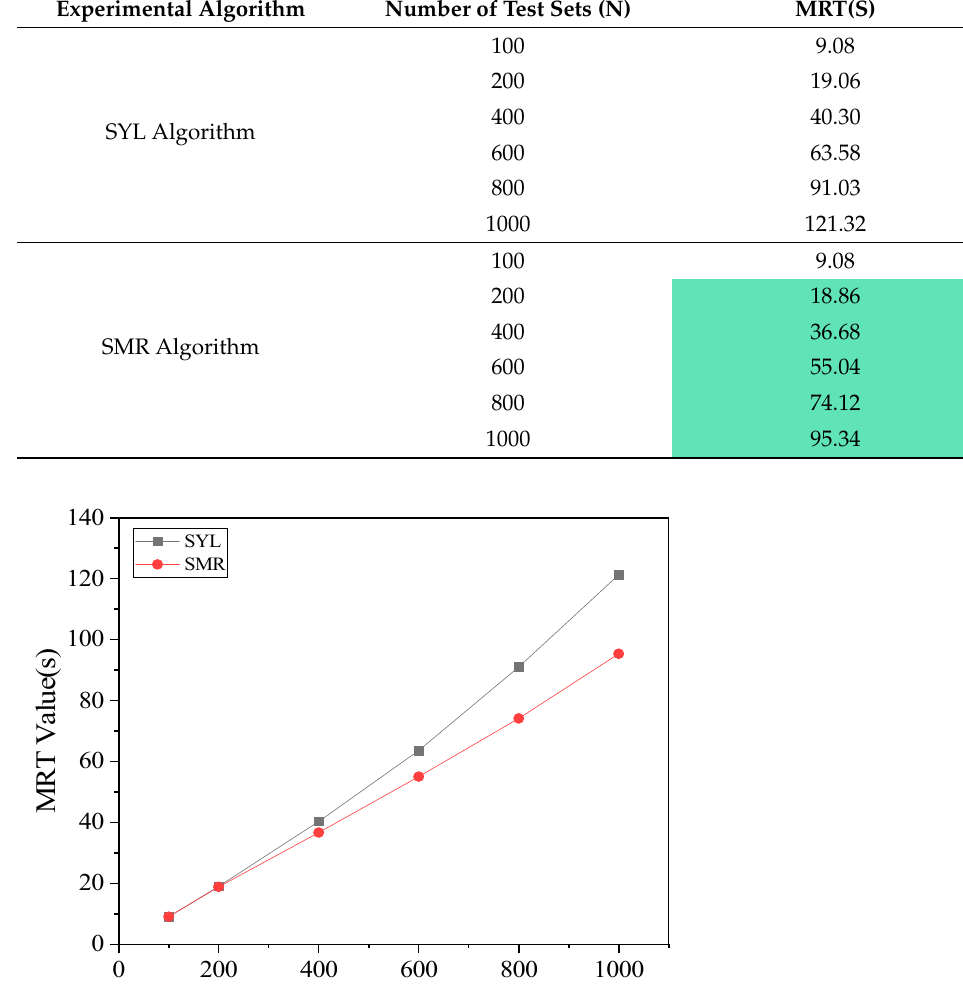
Table 3. MRT values for different data sets.